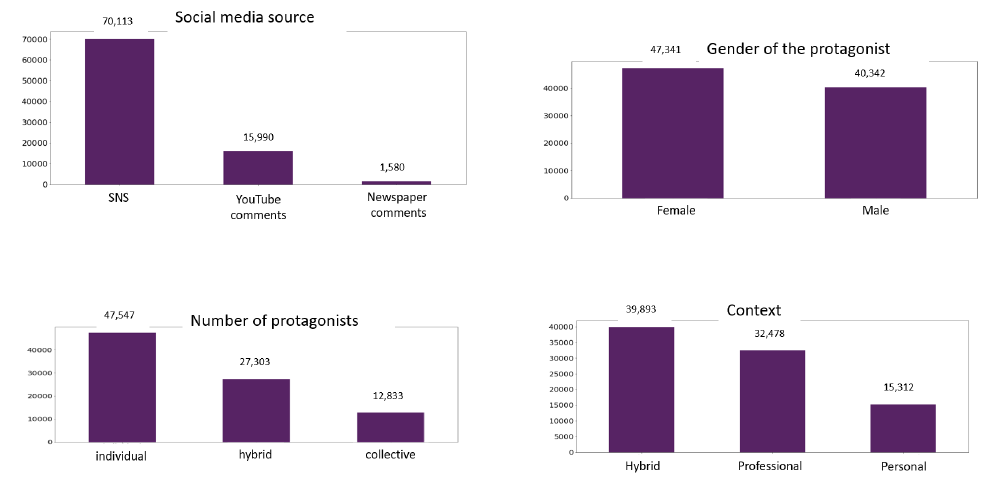
Figure 2. Characteristics of the comments in the data